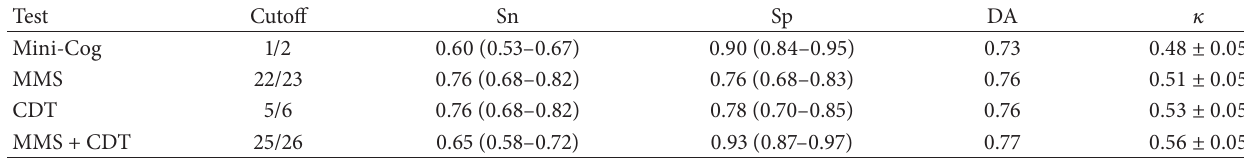
Table 4: Utility of the screening tests for the detection of CI (MCI or dementia) using the best cut